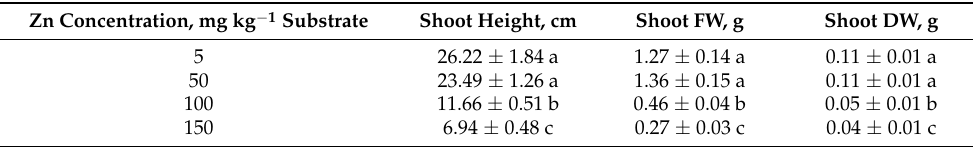
Table 2. Effect of Zn excess on S. alba seedlings height, fresh (FW), and dry weight (DW). Zn Concentration, mg kg − 1 Substrate Shoot Height, cm Shoot FW, g Shoot DW, g